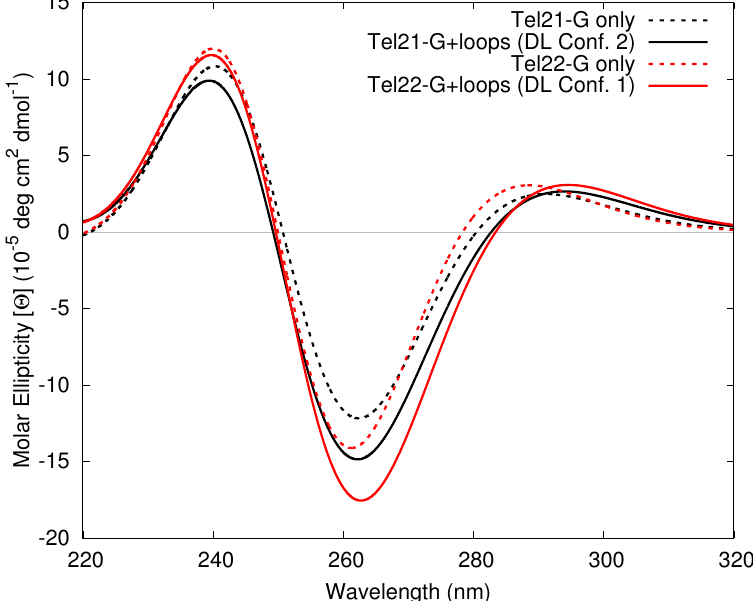
Figure 5. FrDEx computed ECD spectra including all adenine and thymine bases in the LLs and DL, and all G bases of Tel21 100 ns structure GQ with DL in conf. 2 (solid black) and Tel22 100 ns structure with DL in conf. 1 (solid red). Dashed lines indicate the spectra without the contributions from the loops, i.e., with only the G bases. We have not considered A0 base of Tel22 GQ. All FrDEx calculations use pairs as the SC to calculate H inter and H intra . All calculated spectra are shifted by − 0.85 eV.